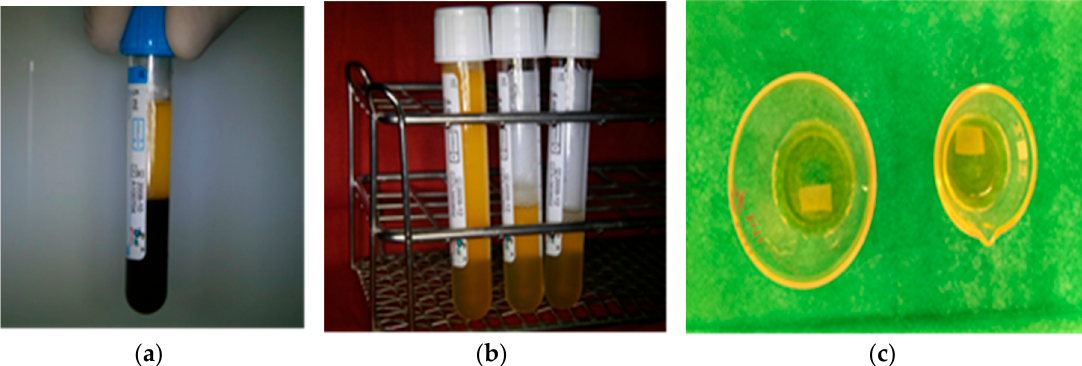
Figure 1. Whole blood separation upon centrifugation at 580 G for 8 minutes at room temperature ( a ) and subsequent platelets rich in growth factor (PRGF) separation by pipetting ( b ); membrane immersion in PRGF ( c ). Table 1. Hematology parameters of whole blood and PRGF fraction.